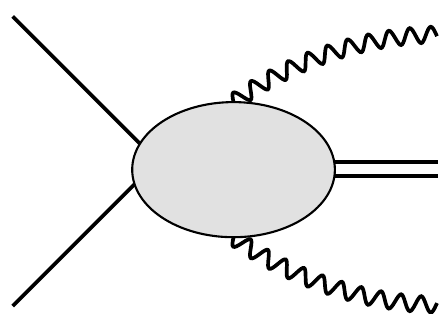
Figure 19 . Schematic diagram for the double radiative transition w 0 w 0 ! ( ww )+ (cid:13)(cid:13) . The double solid line represents the wino-pair bound state ( ww